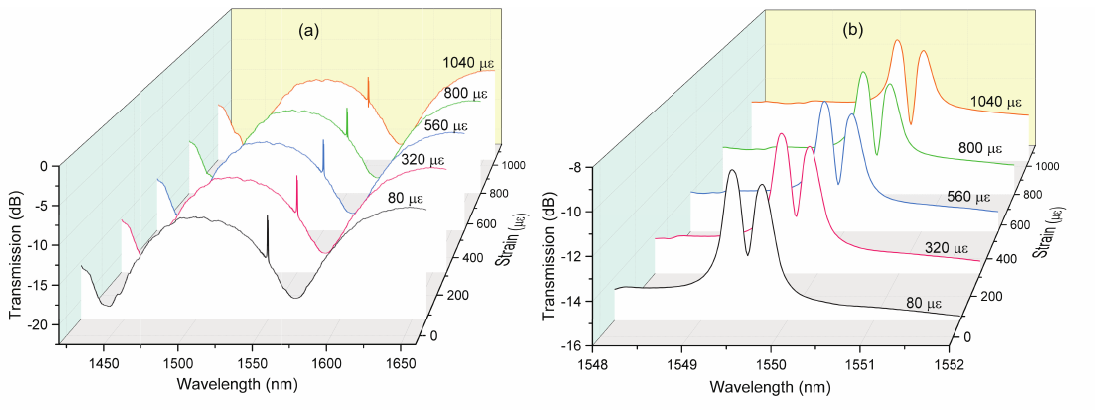
Figure 6. Spectral shifts of Sagnac interference dip ( a ) and Bragg resonant peaks ( b ) with varying axial strain.